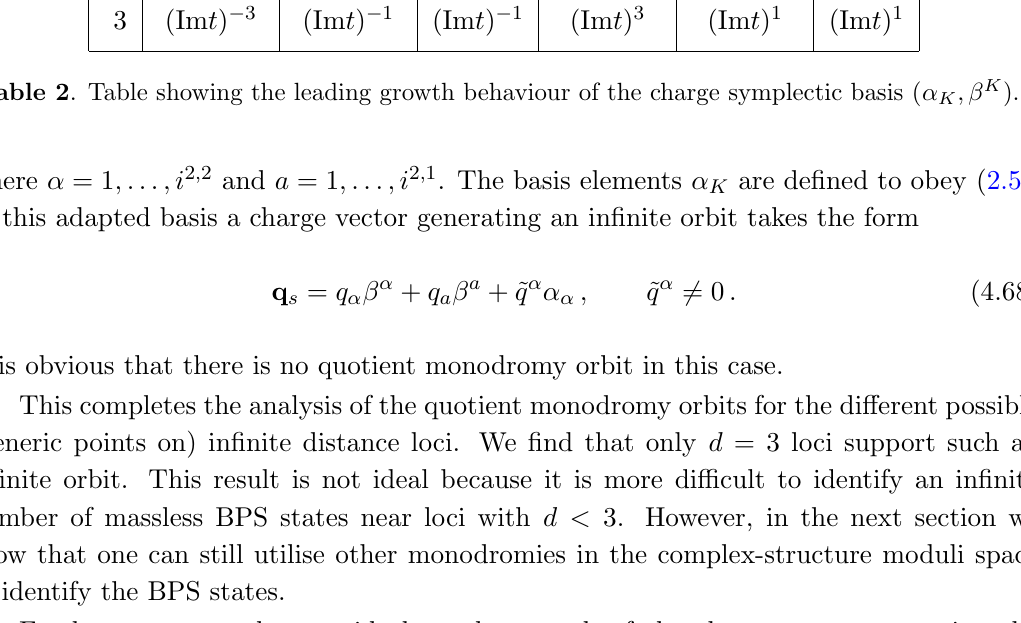
Table 2 . Table showing the leading growth behaviour of the charge symplectic basis ( (cid:11) K ; (cid:12) K ).